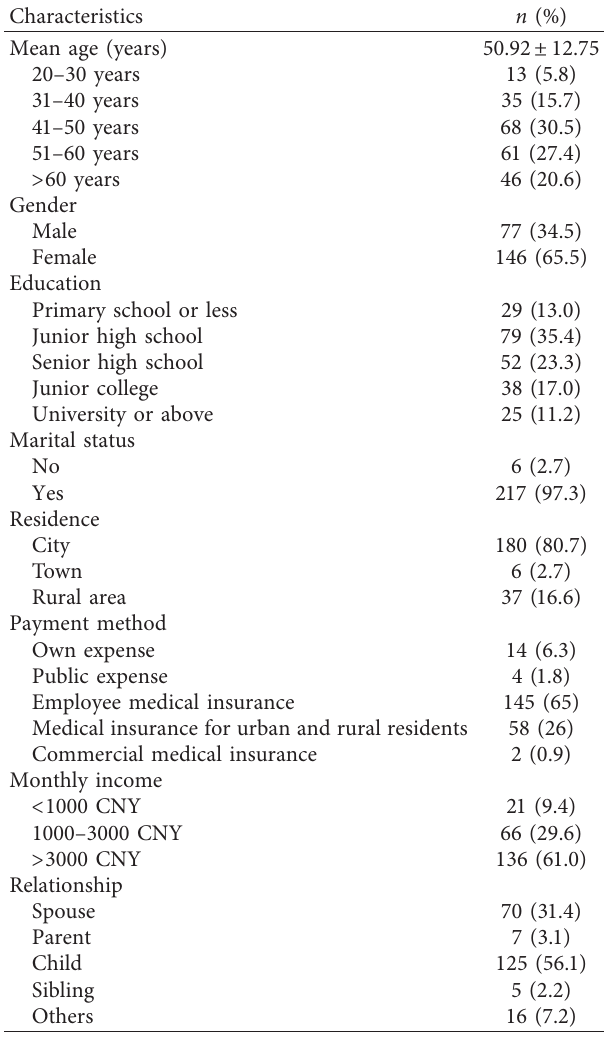
Table 1: Sociodemographic characteristics of family members.